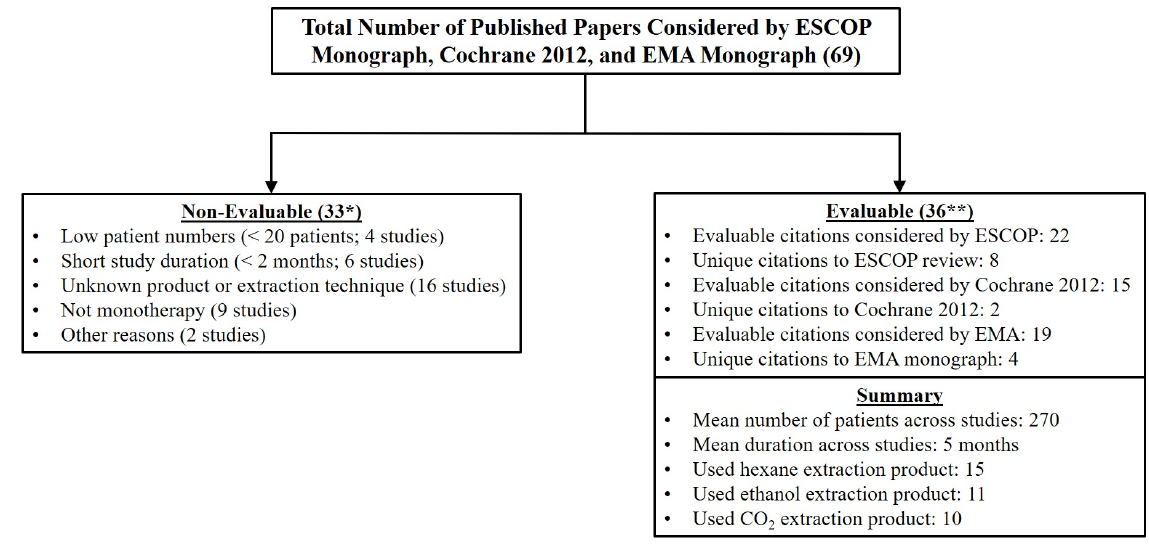
Figure 3. Categorization of 69 evaluable citations in ESCOP 2003, Cochrane 2012, and EMA 2014. * Studies could have more than one reason for exclusion. ** Of the 36 evaluable citations, 22 were considered by ESCOP (61%), 15 by Cochrane (42%), and 19 by EMA (53%). There were eight studies unique to ESCOP, two studies unique to Cochrane. EMA cited four studies not found in either of the other two reviews. CO 2 , carbon dioxide; EMA, European Medicines Agency; ESCOP, European Scientific Cooperative on Phytotherapy. Table 5. Summary of all citations from ESCOP, Cochrane 2012, AUAG, and